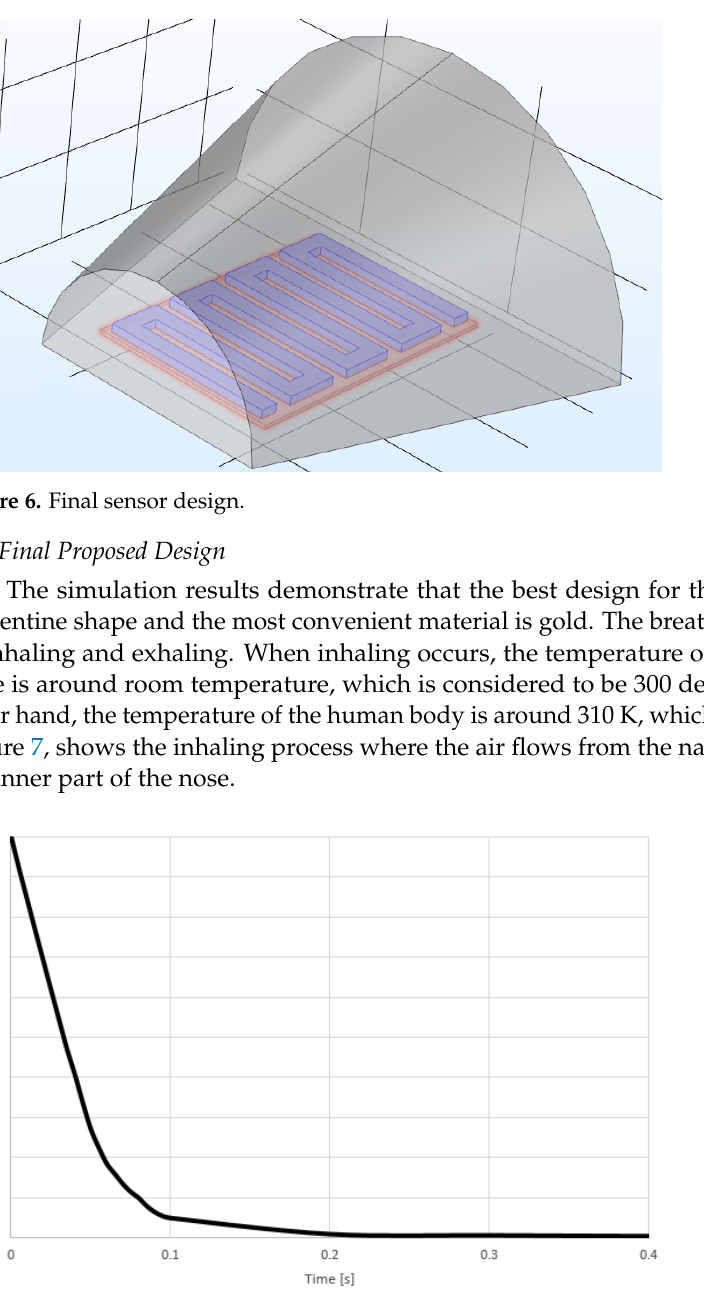
Figure 5. Temperature vs. Time for different materials.